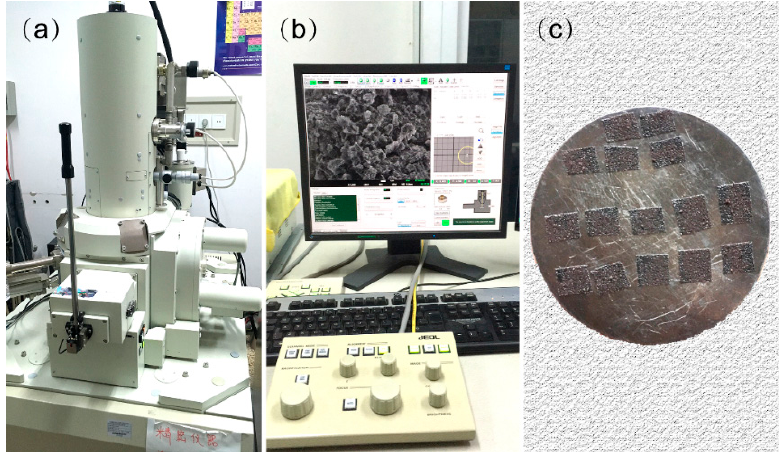
Figure 4. The JSM-7001F and samples. ( a ) The scanning electron microscope (SEM); ( b ) the experiment bench; ( c ) the samples.